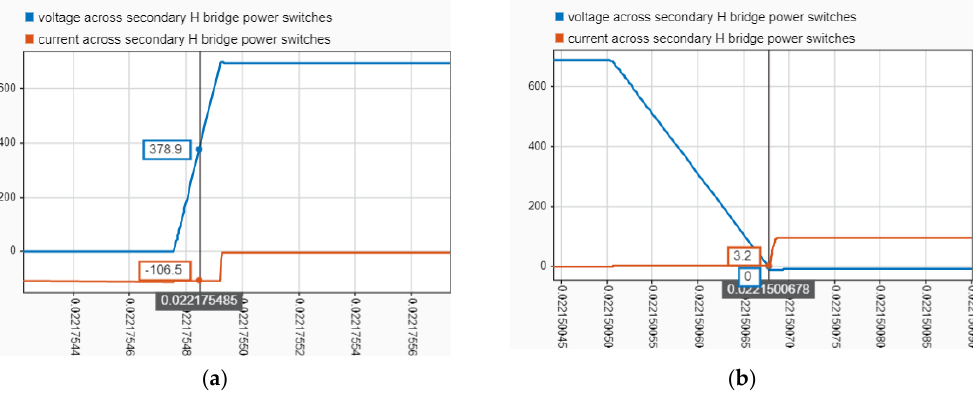
Figure 10 . Current and voltage across a power switch of primary H-bridge for 80 kW DAB DC-DC converter under optimal TrgPS operation, L = 1.57 µ H: ( a ) turn-off; ( b ) turn-on.